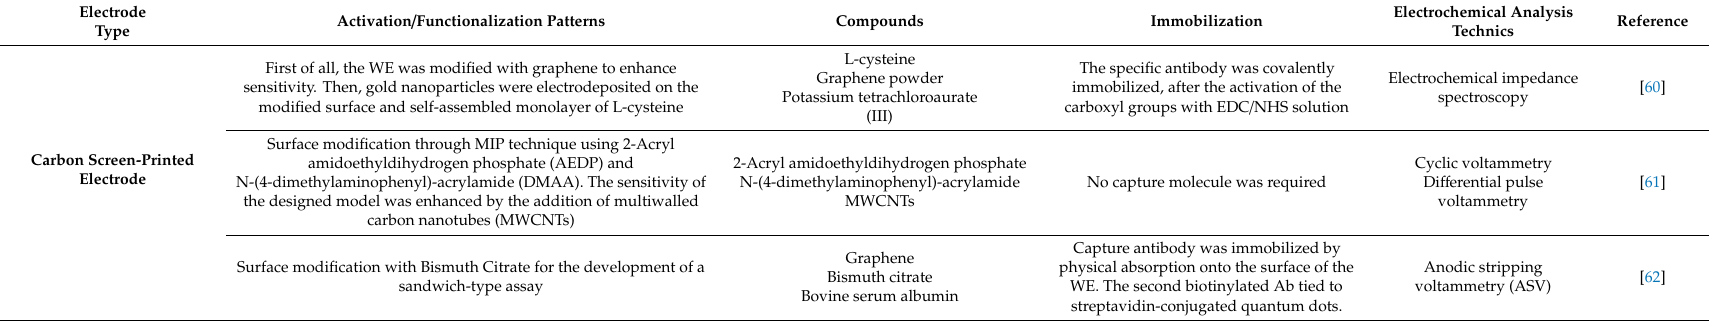
Table 4. Di ff erent designs of SPEs to detect